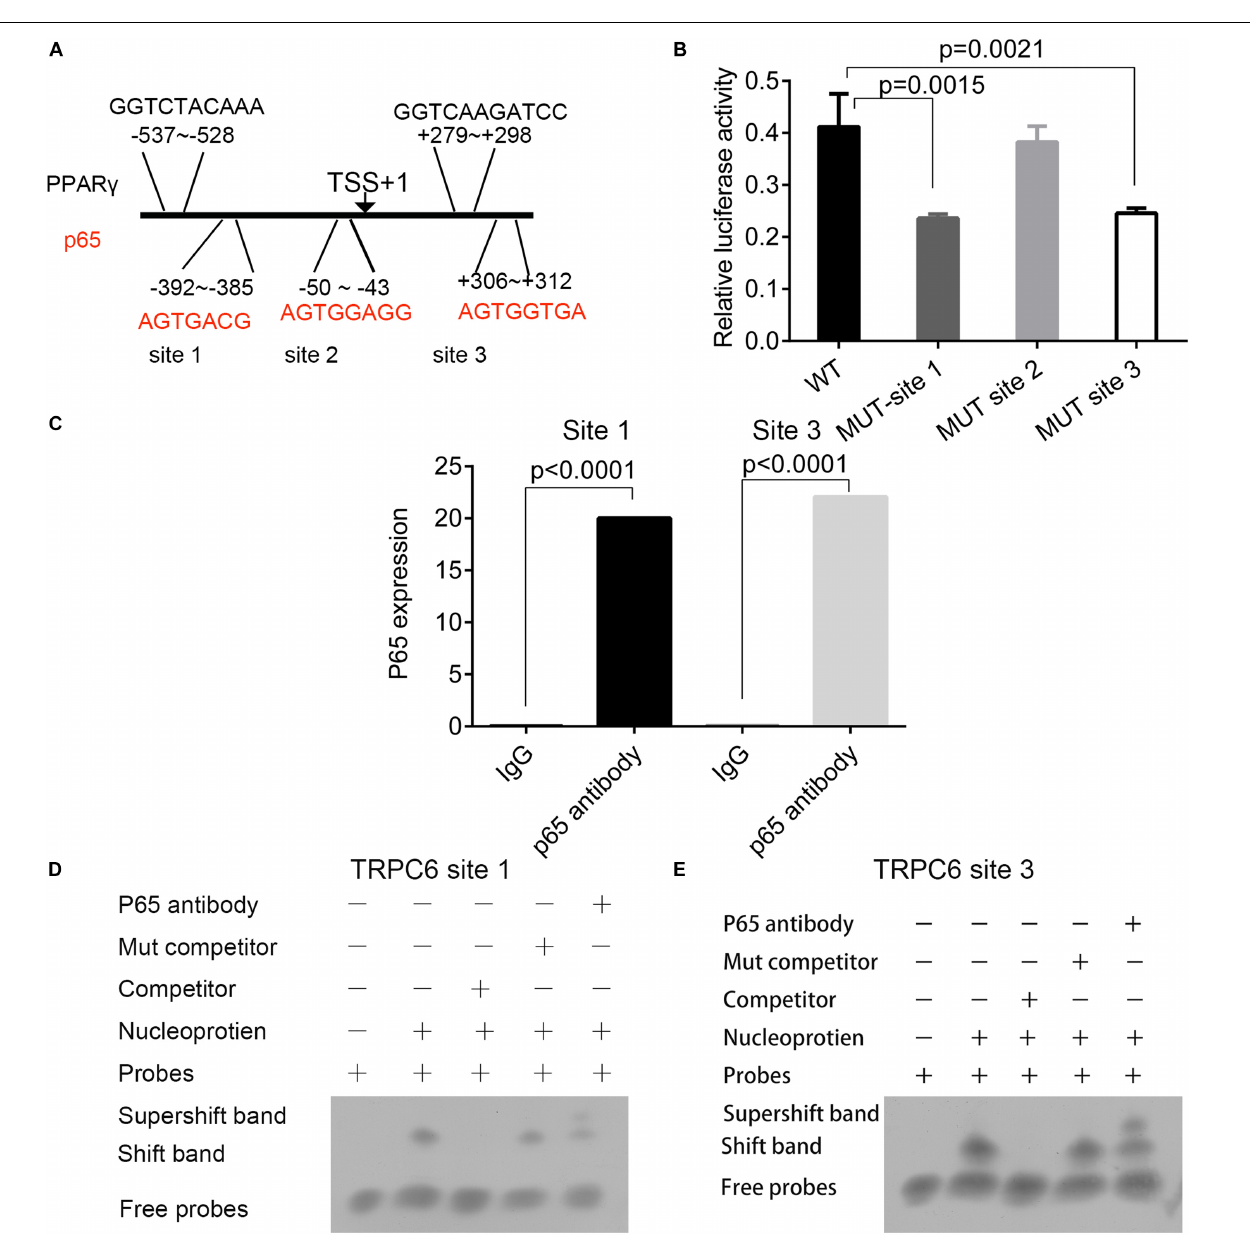
and hypoxia treatment did not affect the expression of PPAR γ